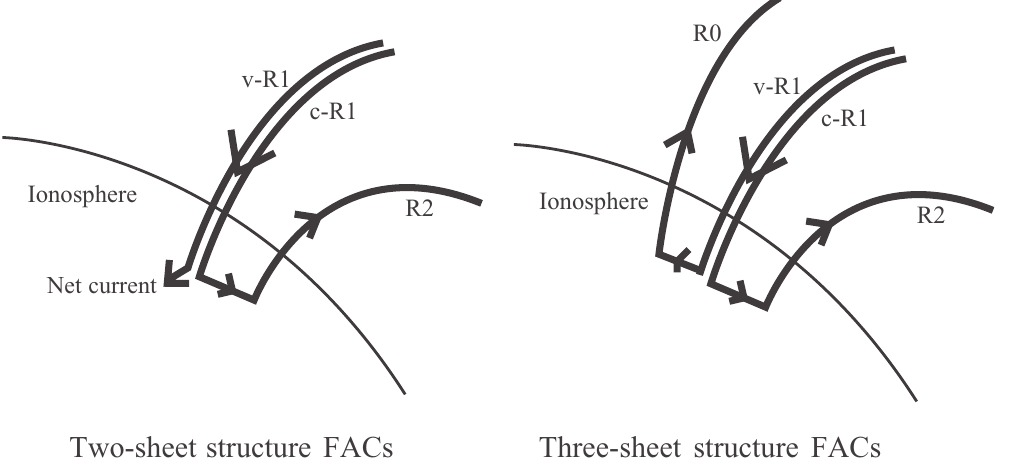
Fig. 6. Illustrates the ionospheric current closure for two-sheet (three-sheet) structure FACs on the left (right) panel.